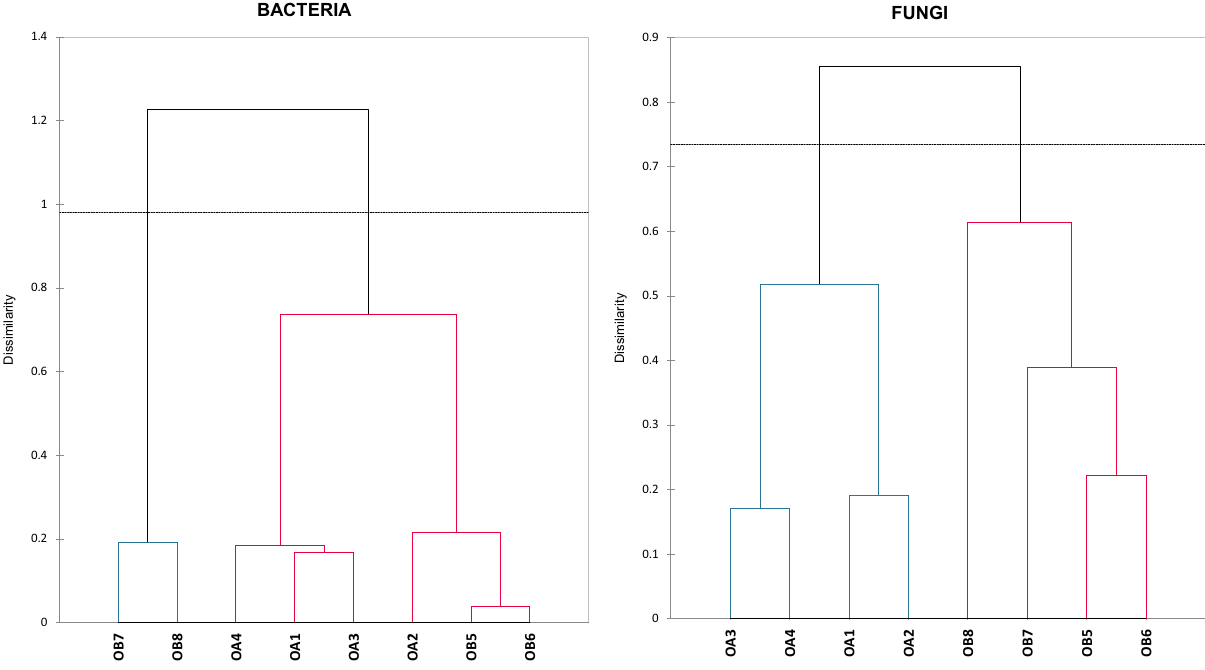
Figure 2. Agglomerative Hierarchy Clustering analysis (Ward’s method based on Bray ‒ Curtis dissimilarity matrix) of distance between phyla and order-representing microbiomes inhabiting Orobanche alsatica (OA) and O. bartlingii (OB) in immature stigmas from closed flowers (1, 2, 5, 6) and mature stigmas from opened flowers (3, 4, 7, 8) (fungi on the right, bacteria on the